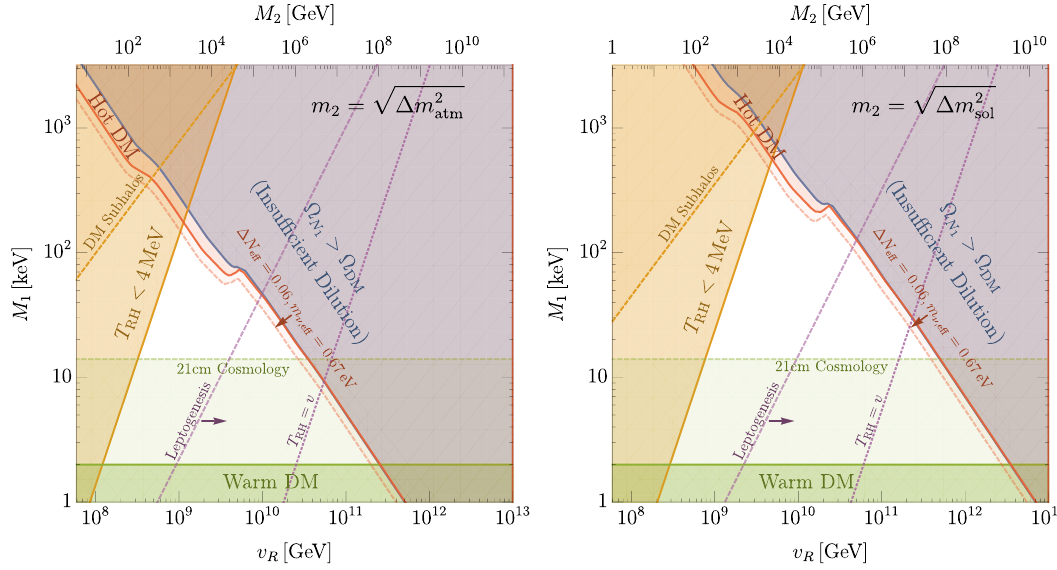
Figure 2 . The parameter space of N 1 DM produced by relativistic freeze-out and dilution from N 2 decay in terms of the left-right symmetry breaking scale, v R , and the mass of N 1 , M 1 , for c = 1. We show constraints from N 2 decaying after Big Bang Nucleosynthesis ( orange ), decaying too early to provide su(cid:14)cient N 1 dilution ( blue ), warm DM bounds ( green ), and hot DM bounds ( red ). In addition we show prospects of future surveys of T RH from pulsar timing on DM subhalos (dashed orange ), improved searches for hot DM from CMB telescopes (dashed red ), and warm DM from 21-cm cosmology (dashed green ). Lastly, to the left of the dashed purple curve